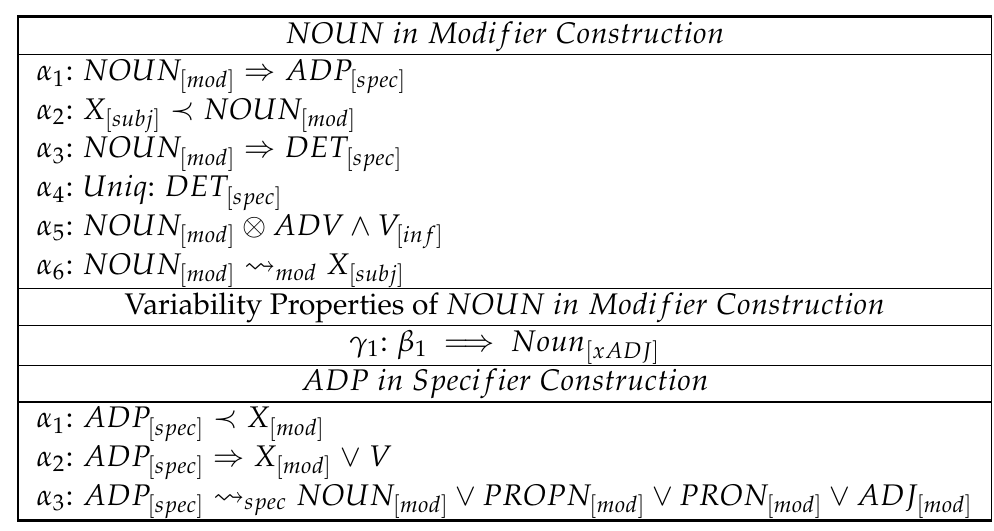
Table A3. Spanish properties of both NOUN in modifier and ADP in specifier